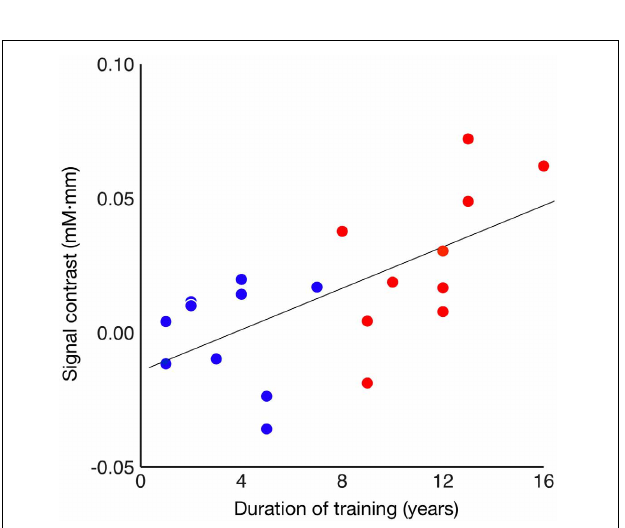
FIGURE 2 | Average time series data of the oxy-Hb concentration changes after stimulus onset. The results of the familiar (blue lines) and unfamiliar (red lines) conditions for well-trained (A) and less-trained (B) participants are shown. The yellow area indicates the stimulation period.